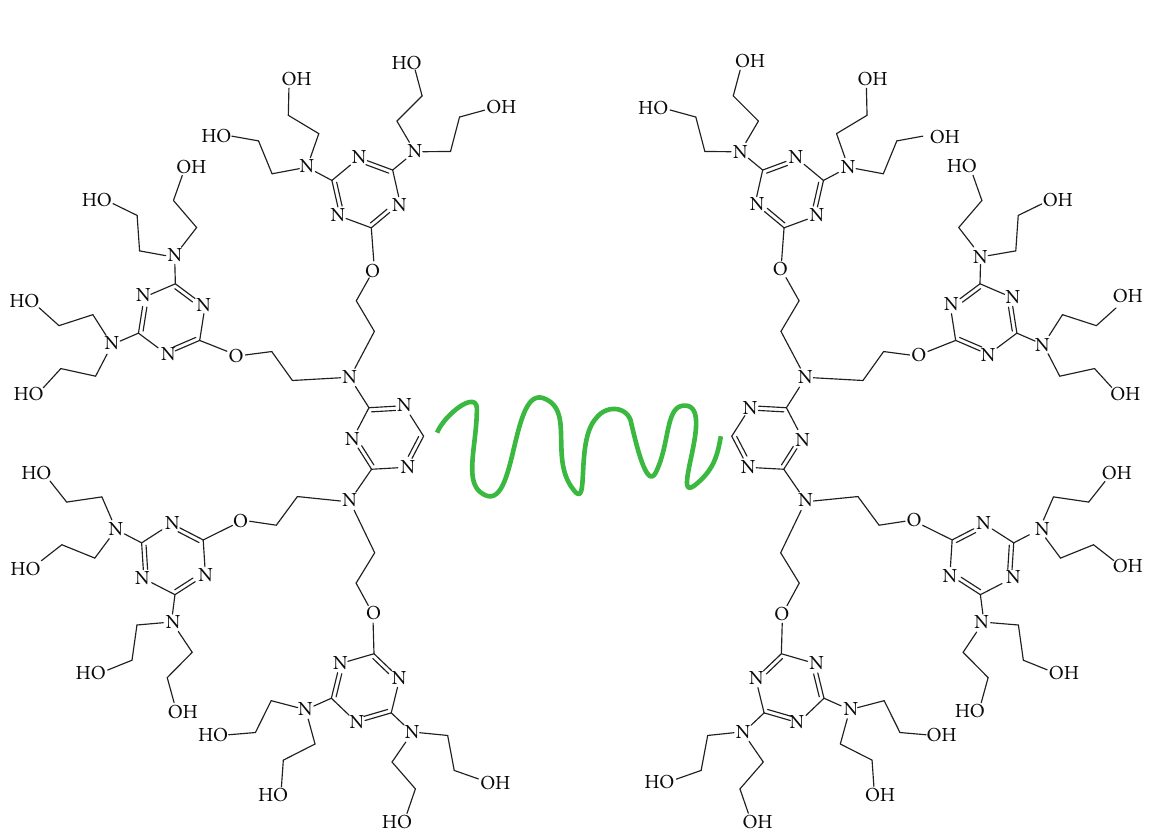
Figure 3: PEG-cored triazine dendrimer